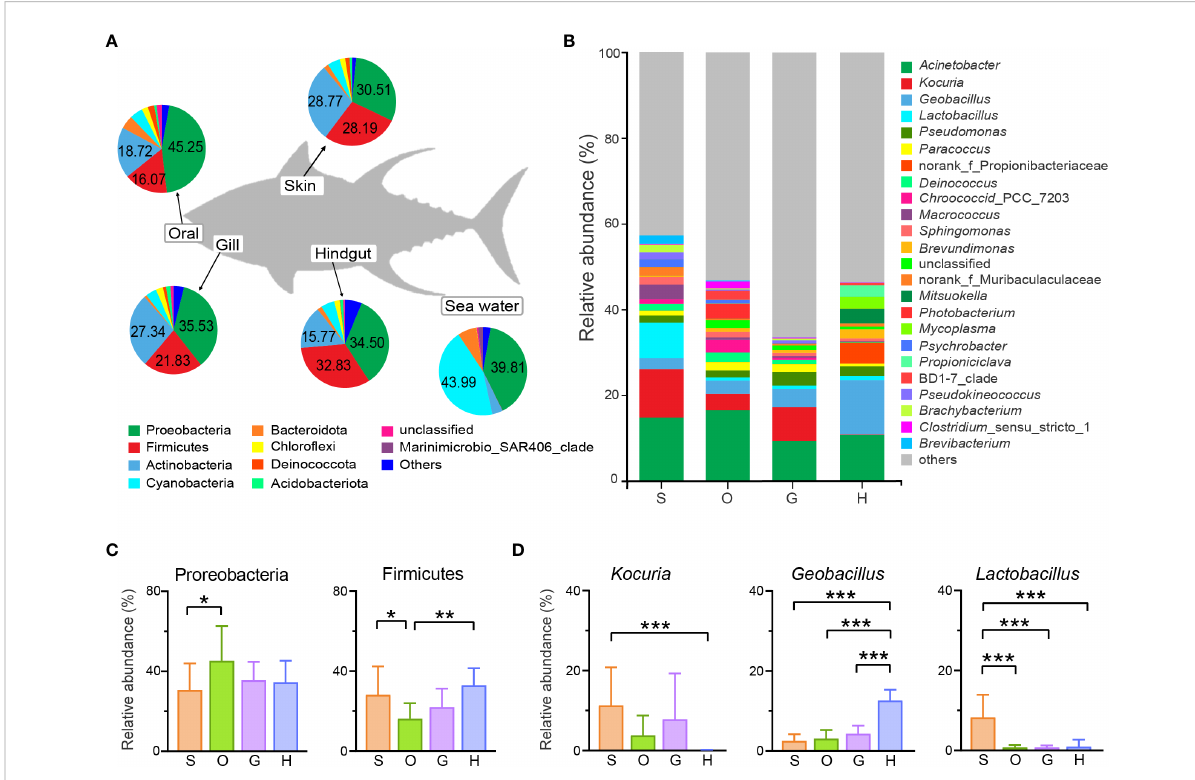
FIGURE 3 Relative abundance of the bacterial community. The microbial abundance of tunas and seawater at the (A) phylum level and (B) genus level. OTUs with low relative abundance (<1.5%) were clustered in “ others ” . The signi fi cant differences analysis of (C) abundant phyla and (D) abundant genera. Statistical test was carried out by the Kruskal-Wallis H Test followed by Bonferroni correction (* p ≤ 0.05; ** p ≤ 0.01; *** p ≤ 0.001). S, skin; O, oral; G, gill; H,